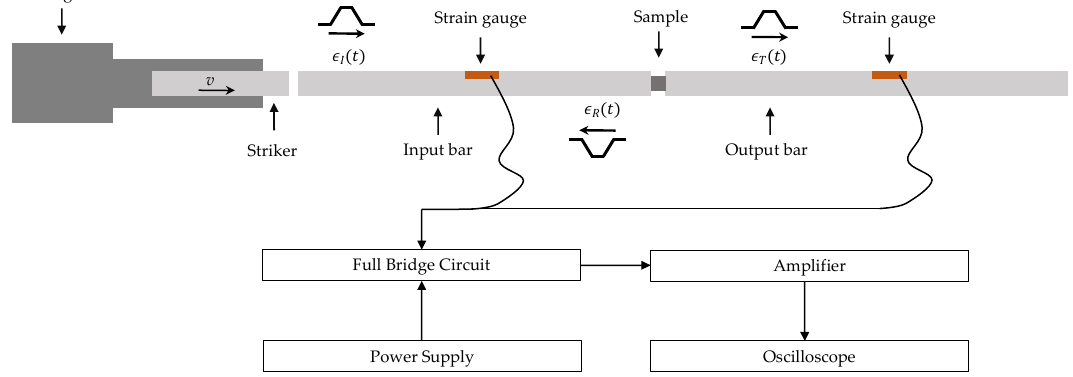
Figure 6. A schematic illustration of split Hopkinson bar pressure (SHPB) apparatus [15].